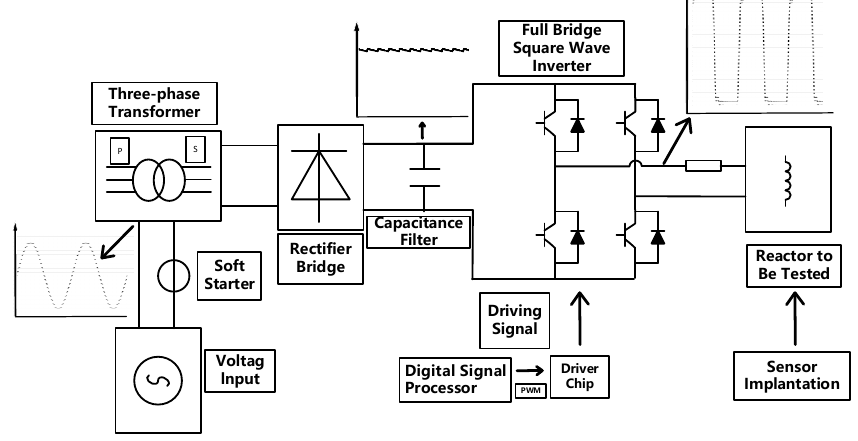
Figure 9. Experimental circuit and waveforms. DSP: (Digital Signal Processor).